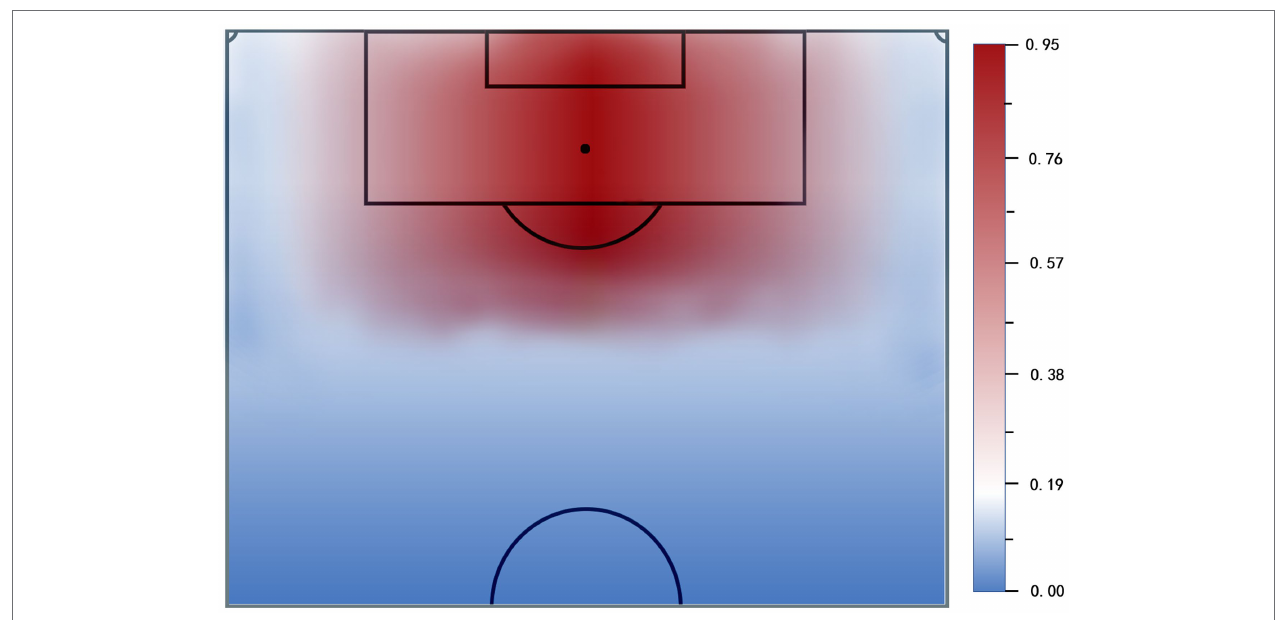
FIGURE 2 | Expected conversion probabilities of shots on the pitch. The darker the red, the higher the expected